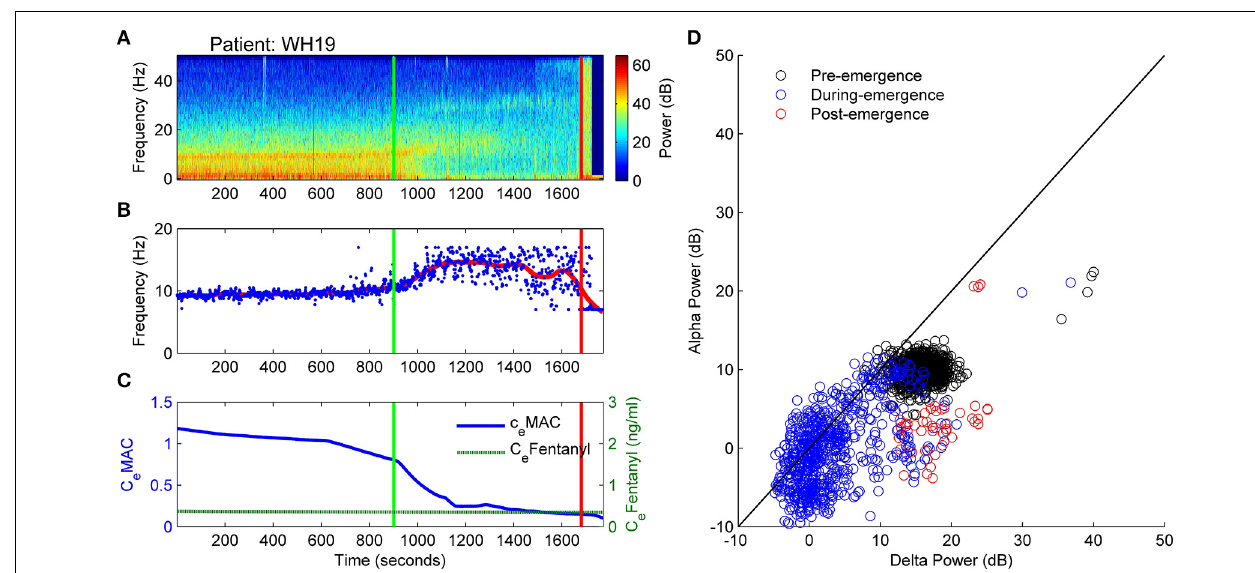
FIGURE 4 | Patient WH19: Archetypal emergence (alpha frequency increase, alpha loss, delta loss). (A) Spectrogram of the observation period. Start of emergence shown as a vertical green line at 900s, time of patient response as a vertical red line. (B) Frequency of maximal oscillatory alpha power. (C) Concentration of anesthetic gas (C e MAC),